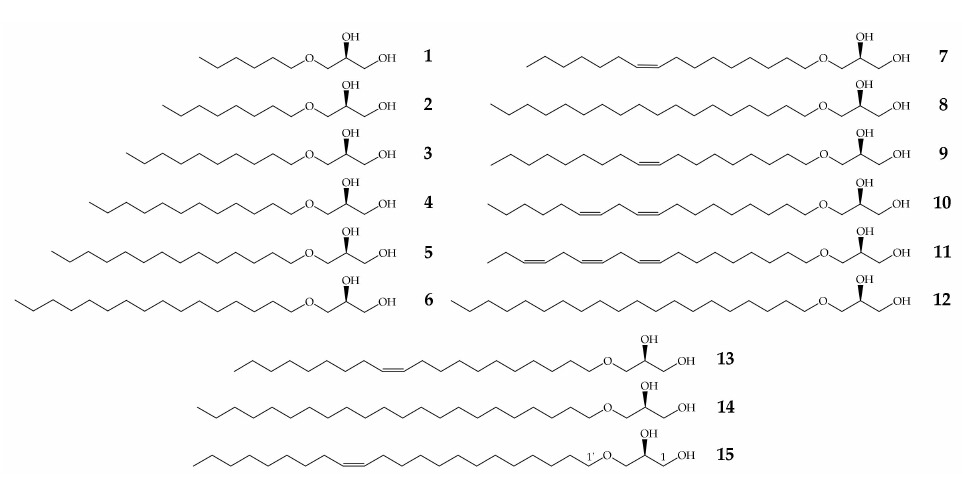
Figure 1. Structures of alkylglycerols used in this study.